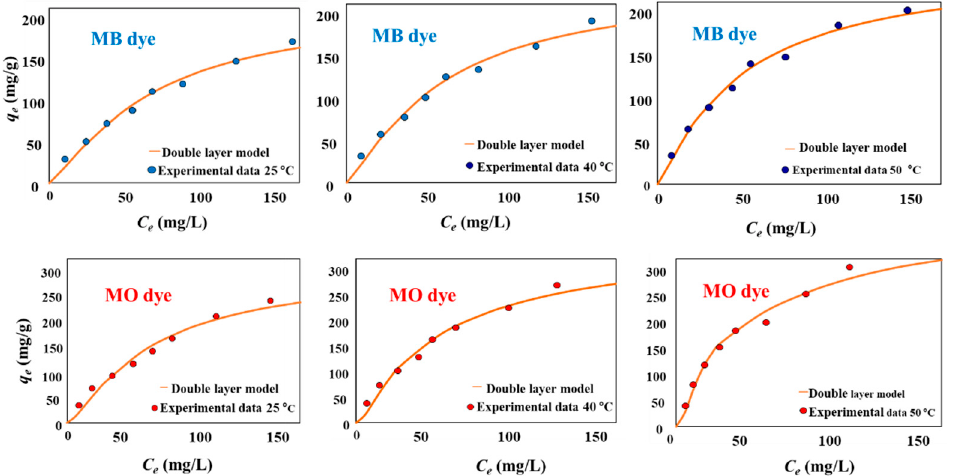
Figure 5. Advanced statistical physics modeling of adsorption isotherms of MO and MB dyes on Rt/BC composite. The double layer model describe well (i.e., R 2 > 0.98) the adsorption of MB and MO on the Rt/BC adsorben.